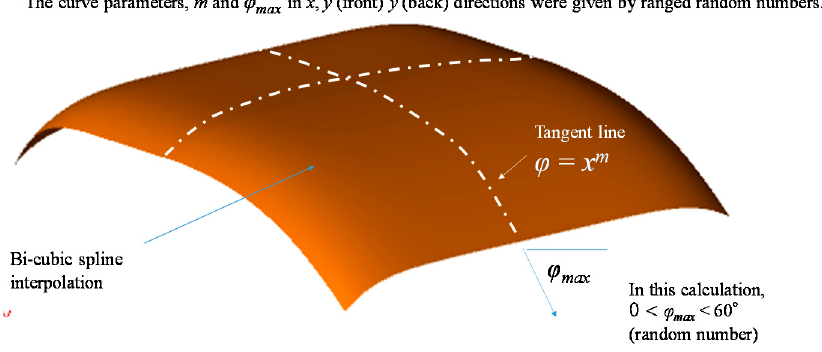
Figure 9. Modeling the curved surface of the car roof PV using random numbers.